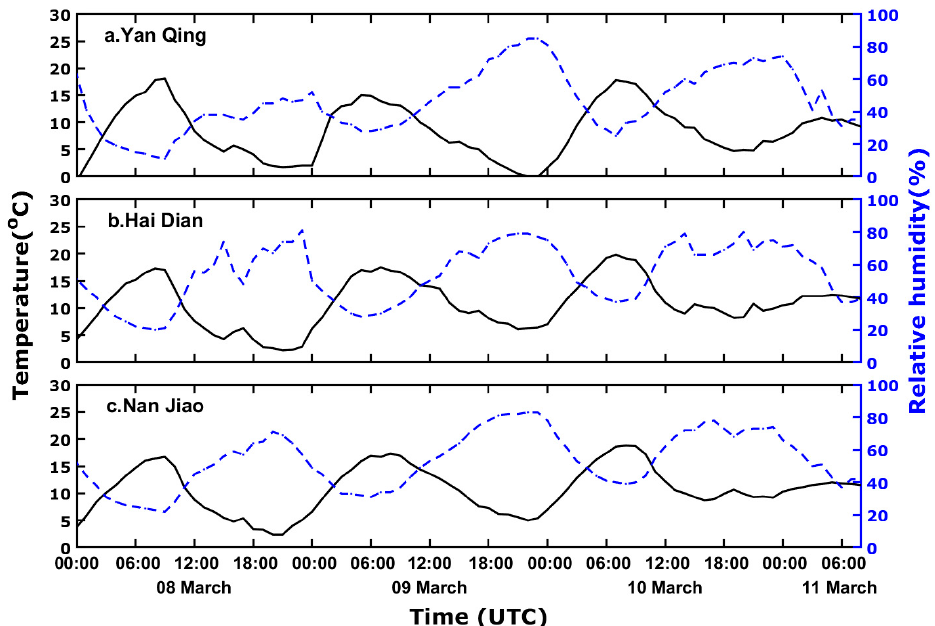
Figure 13. Temperature and humidity on the surface of each region (( a ). Yanqing, ( b ). Haidian, and ( c ). Nanjiao).